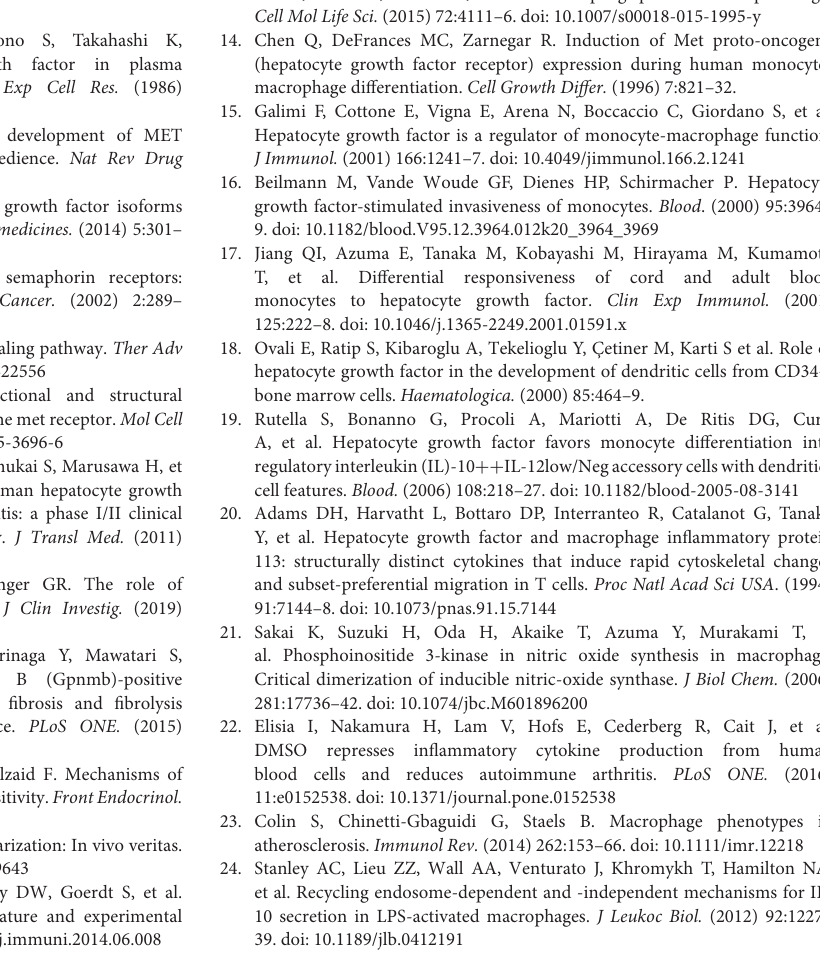
Supplemental Table 1 | All primers and antibodies used in this study are